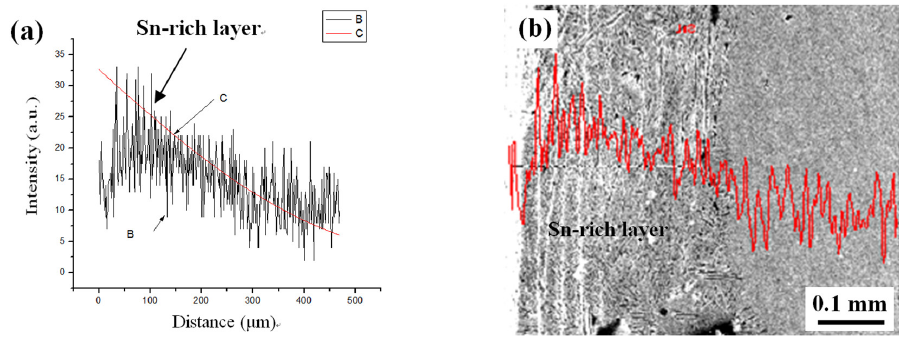
Figure 11. Comparison between the computational result ( a ) and the experimental EDS line-scan